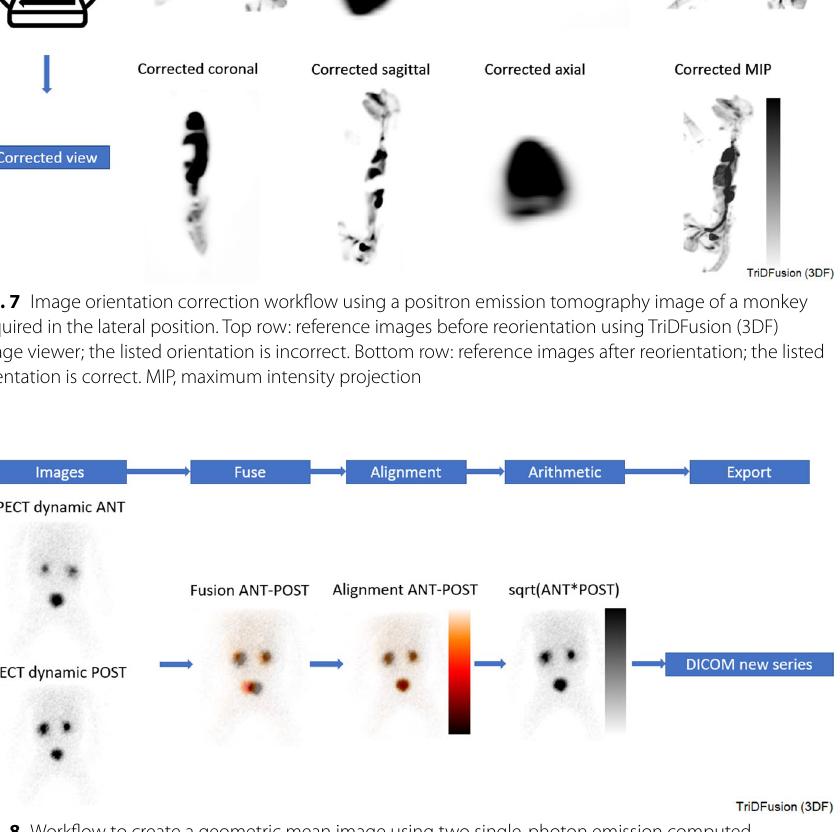
Fig. 8 Workflow to create a geometric mean image using two single-photon emission computed tomography (SPECT) images. ANT, anterior; POST,